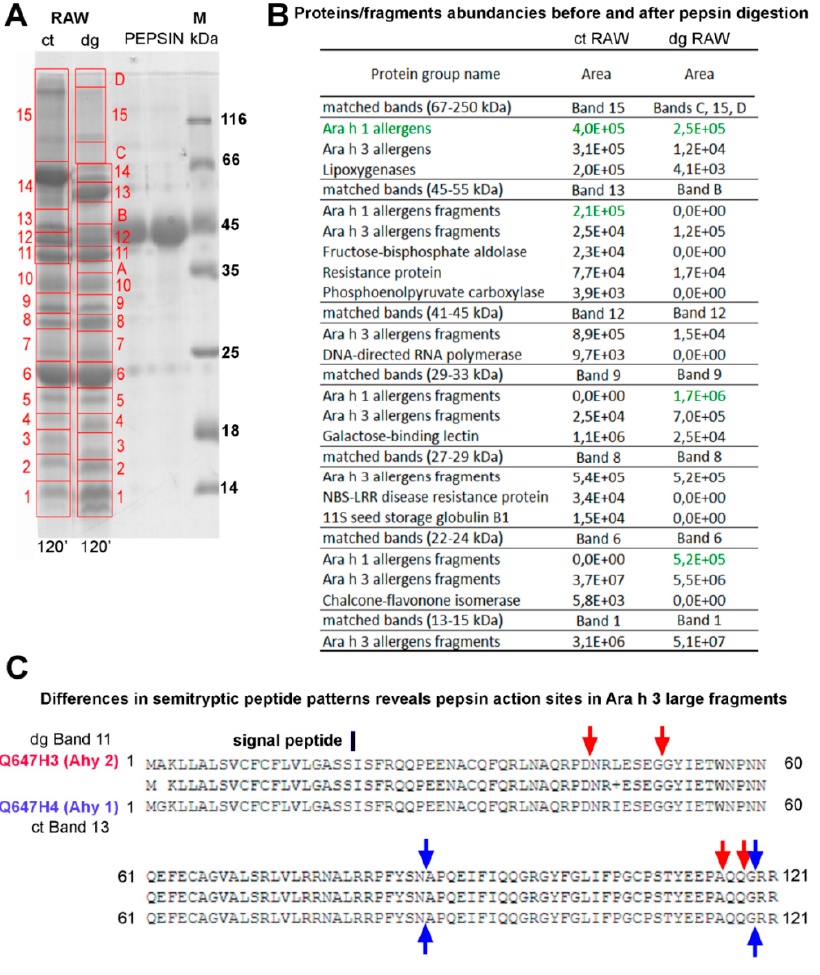
Figure 7. Protein and fragment identification in gastric digestion control and digested samples of raw peanuts by high-resolution tandem mass spectrometry. A —Excision map with protein / fragment identifications and their abundancies per excised band. SDS-PAGE was performed in reducing and non-reducing conditions on 14% gels. ct—control at 120 min; dg—digest at 120 min; PEPSIN—controls containing only pepsin at 0 and 120 min; M—molecular weight markers. B —Protein / fragment abundancies before and after pepsin digestion. C —Sequence alignment of Ara h 3 acidic subunit fragment homologs found at molecular weights of at least 40 kDa, showing nonspecific proteolysis with blue arrows and those unique to the digested sample (a result of the pepsin action) with red arrows.